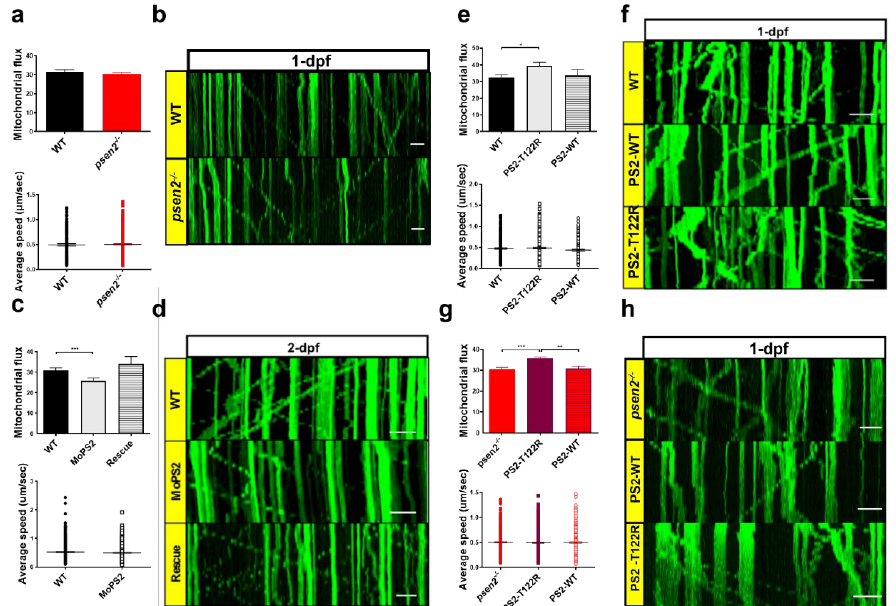
Figure 5. Effect of Psen2 genetic manipulation on mitochondrial axonal transport. ( a ) Mitochondrial flux ( n of axons > 35/condition) and average speed ( n of mitochondria > 200/condition) quantification in WT and psen2 − / − 1-dpf zebrafish embryos. Data were generated from more than 5 independent experiments. ( b ) Representative kymographs showing mitochondrial movement in WT and psen2 − / (MoPS2) > 50; rescue = 14) and average speed ( n of mitochondria > 500 /condition) quantification in